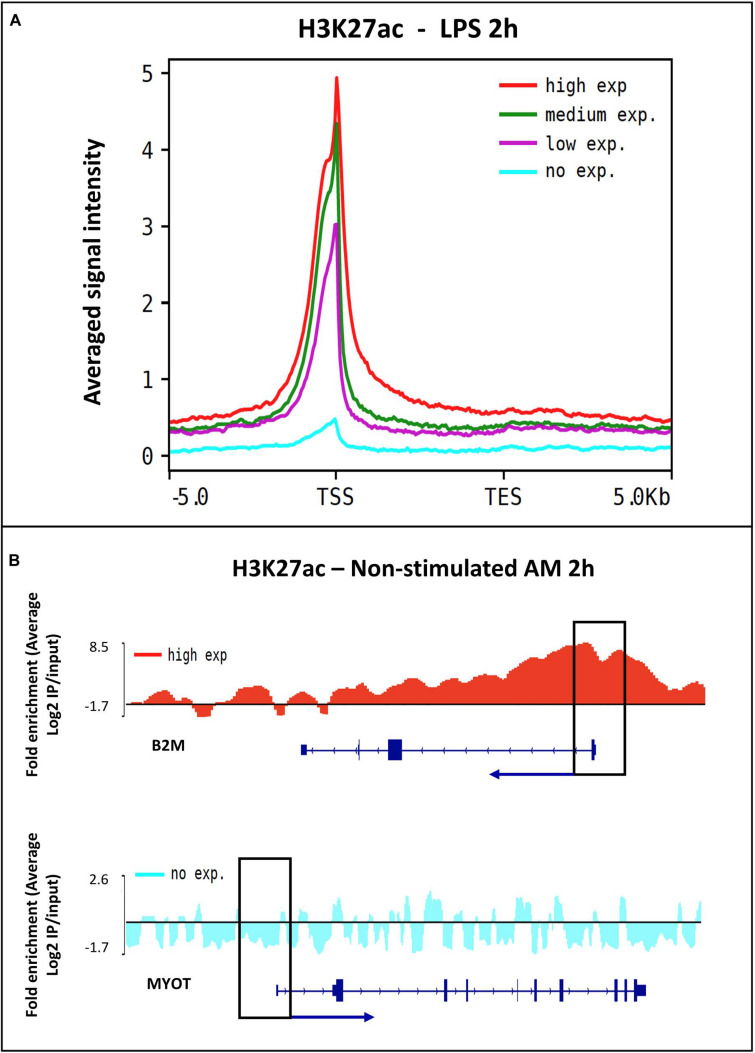
The relationship between H3K27ac signal and gene expression. (A) Histogram of the H3K27ac signal intensity and all expressed genes in alveolar macrophages stimulated with LPS treatment at 2 h. Genes were divided into four quartiles, high expression (red), middle high (green), middle low (purple) and low expression (blue). (B) Peak visualization using the Integrative Genomics Viewer (IGV) of a highly expressed gene ACTB and a low expressed gene MYOT in non-stimulated alveolar macrophages.